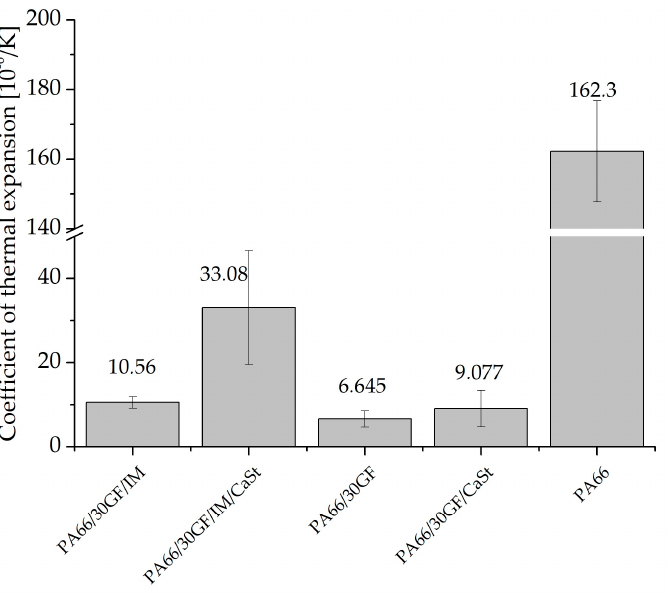
Figure 8. Thermal expansion exponent of compounds.